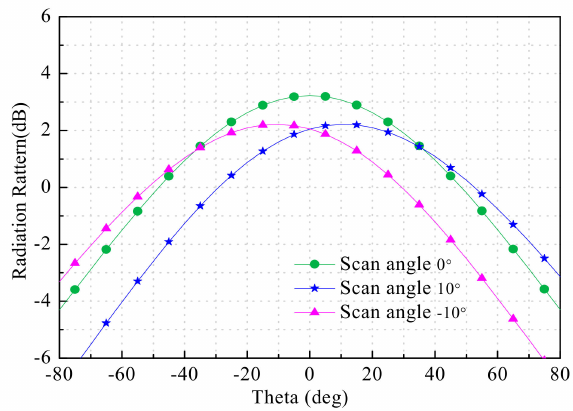
Figure 7. Simulated radiation patterns ( ϕ = 30 ◦ plane) θ = 0 ◦ ( m = 12) and θ = ± 10 ◦ ( m = 7) at 0.5 THz.